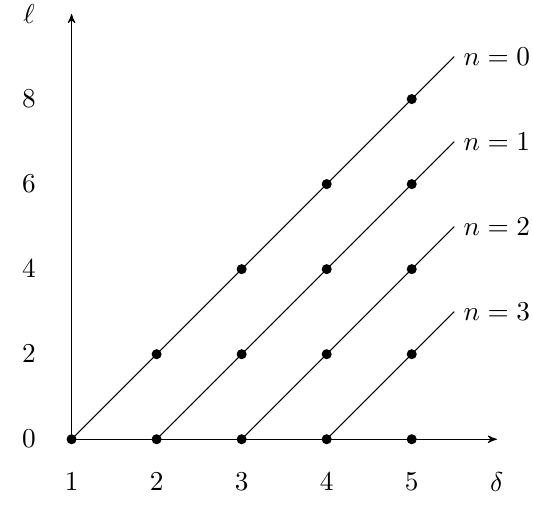
Figure 2 . Chew-Frautschi plot of the stringy